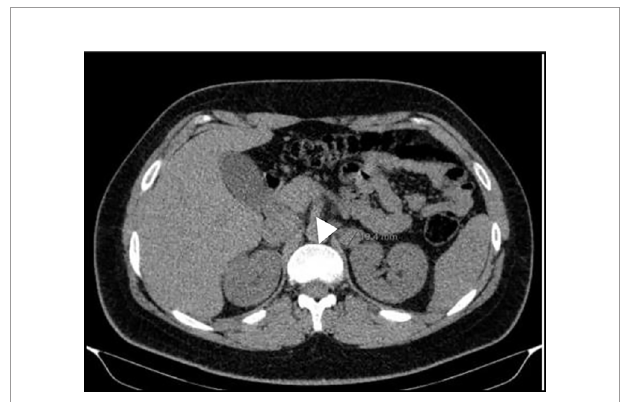
FIGURE 3 | Abdominal-CT scan before left adrenalectomy showing a 17mm nodule on the left adrenal gland.